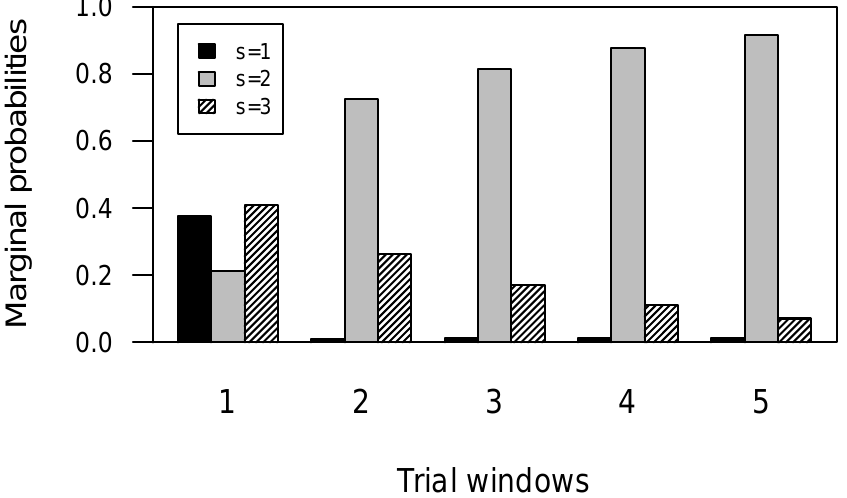
Figure 5. Marginal distribution of the latent states for each task phase, for the SDI